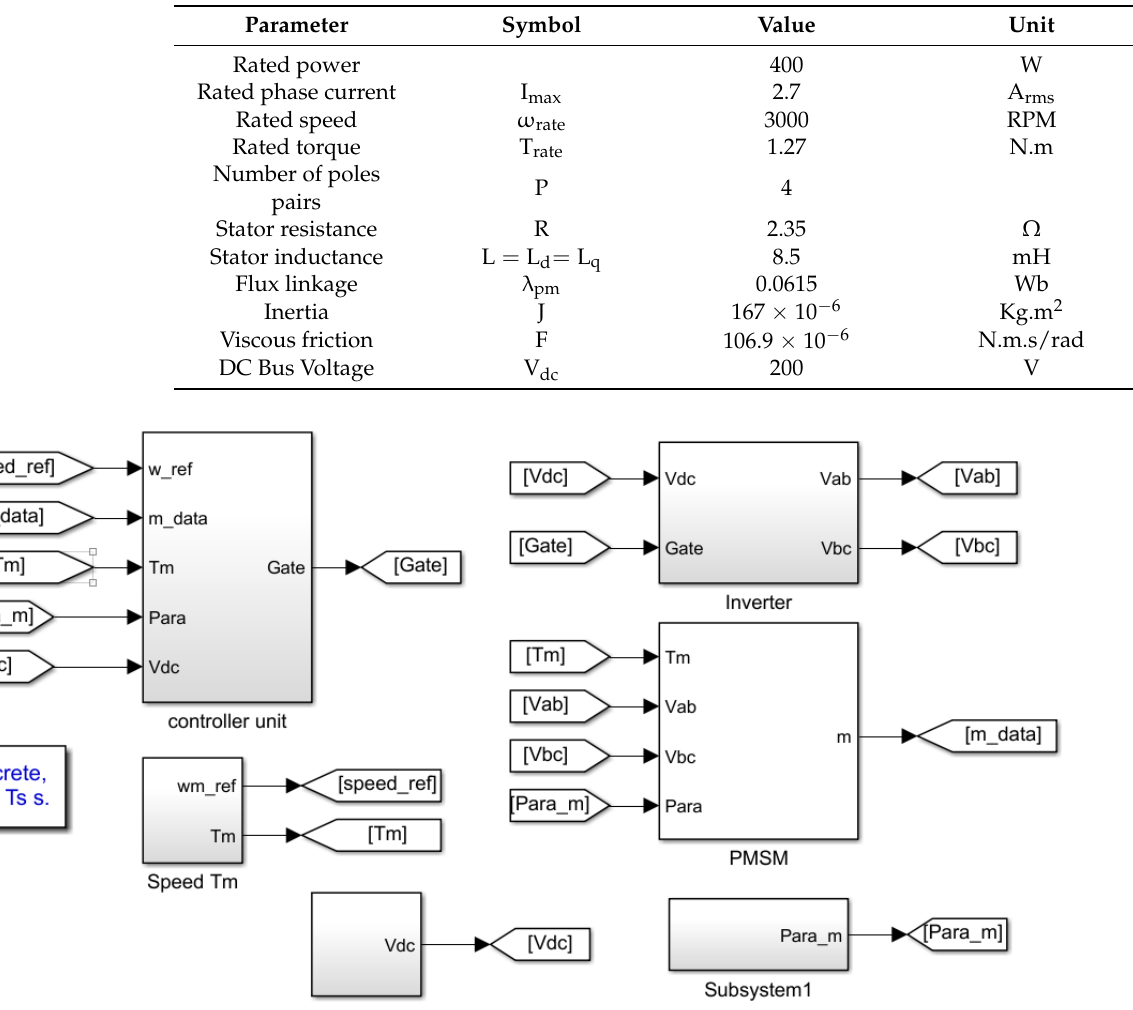
Table 1. PMSM parameters.